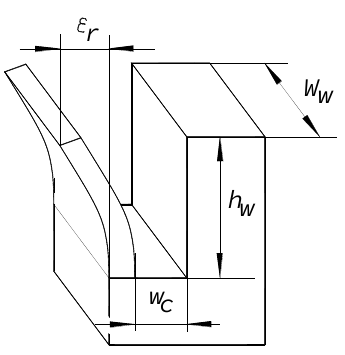
Figure 4. Dimensions that characterize the thin wall’s bending when machining with a disc cutter.